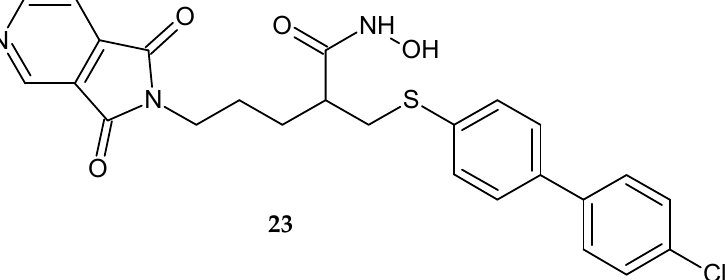
Figure 18. 5 ‐ (1,3 ‐ Dioxo ‐ 1,3 ‐ dihydro ‐ 2 H ‐ pyrrolo[3,4 ‐ c ]pyridin ‐ 2 ‐ yl) ‐ 2 ‐ {[(4’ ‐ chloro[1,1’ ‐ biphenyl] ‐ 4 ‐ yl)sulfanyl]methyl} ‐ N ‐ hydroxypentanamide 23 .